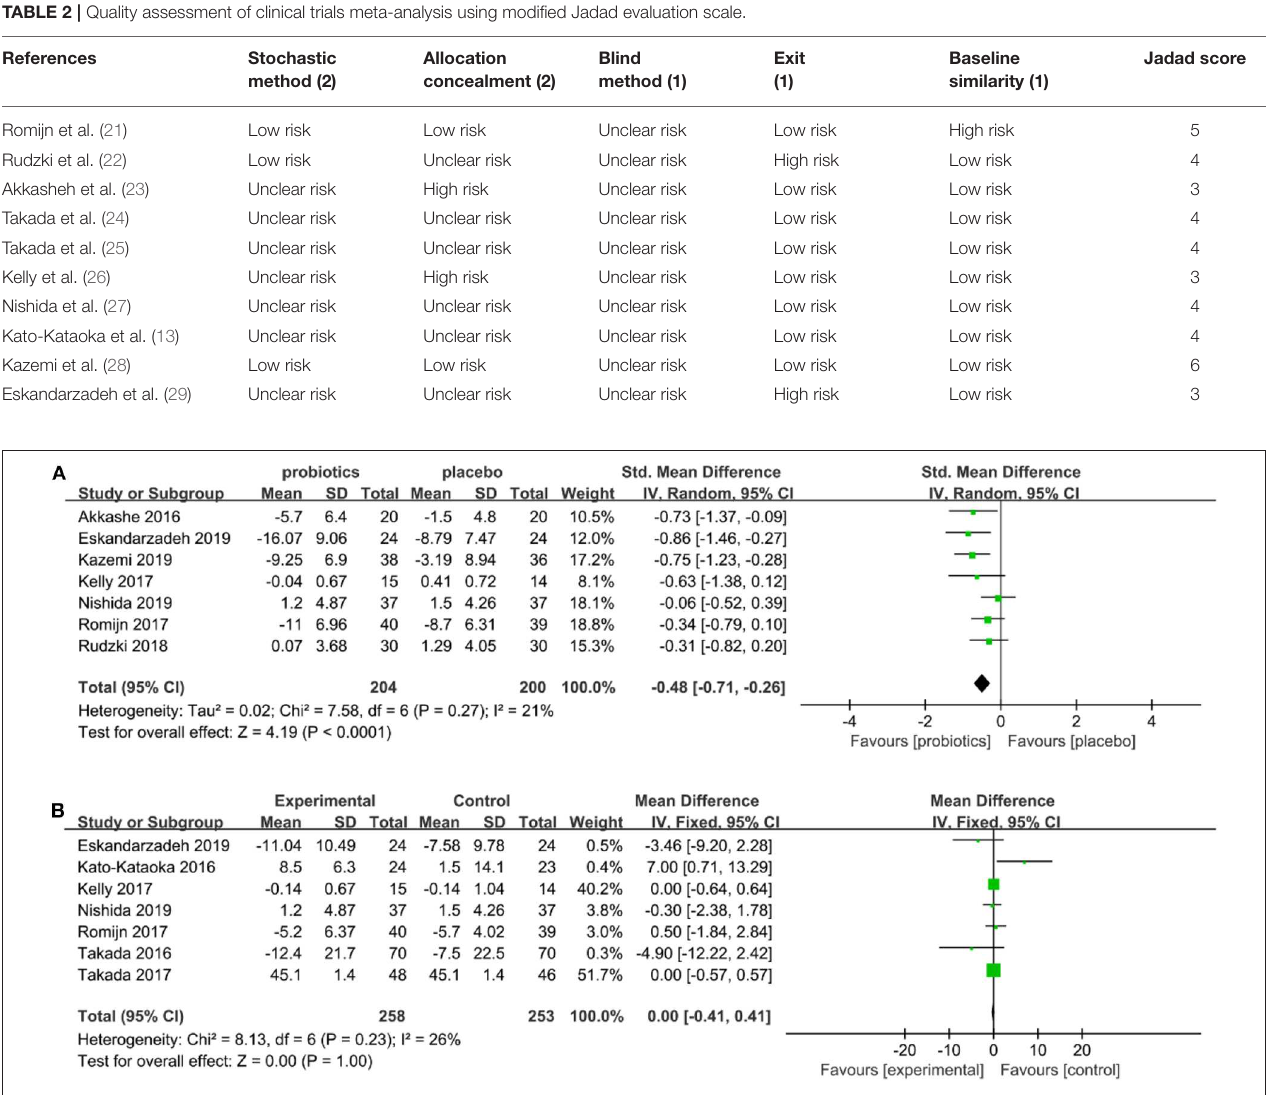
FIGURE 2 | (A) Forest plots for depression status. (B) Forest plots for anxiety